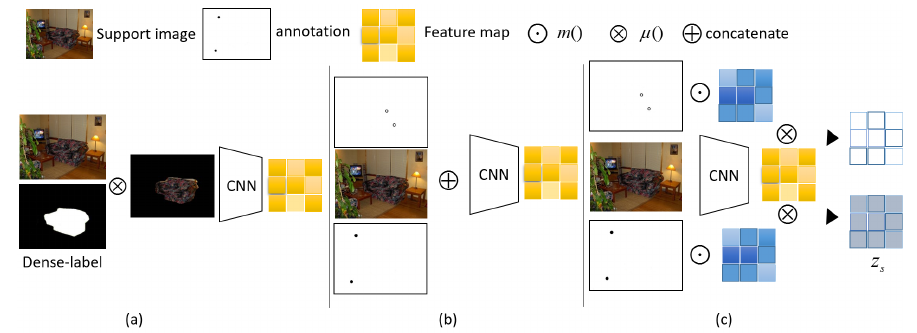
Figure 4. The main differences in guidance branch: ( a ) Shaban et al. [39] used multiple support images and directly dense labelled, and the background was omitted. ( b ) Xu et al. [41] concatenated on the support image and annotation maps, which breaks the input structure of the net. ( c ) Our proposed fusion method: the guidance branch combines annotation and support image in feature level, which maintains the identical net structure and complete background information.